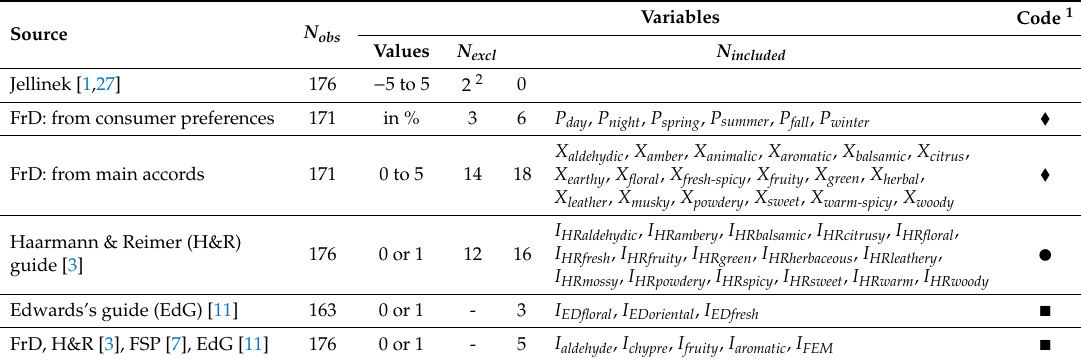
Table 1. List of variables compiled from Fragrantica’s website (FrD) and di ff erent catalogs for the set of 176 fragrances used by Jellinek [1,27]: number of observations ( N obs ), number of variables excluded ( N excl ), and variables included in the multivariate analysis (48 in